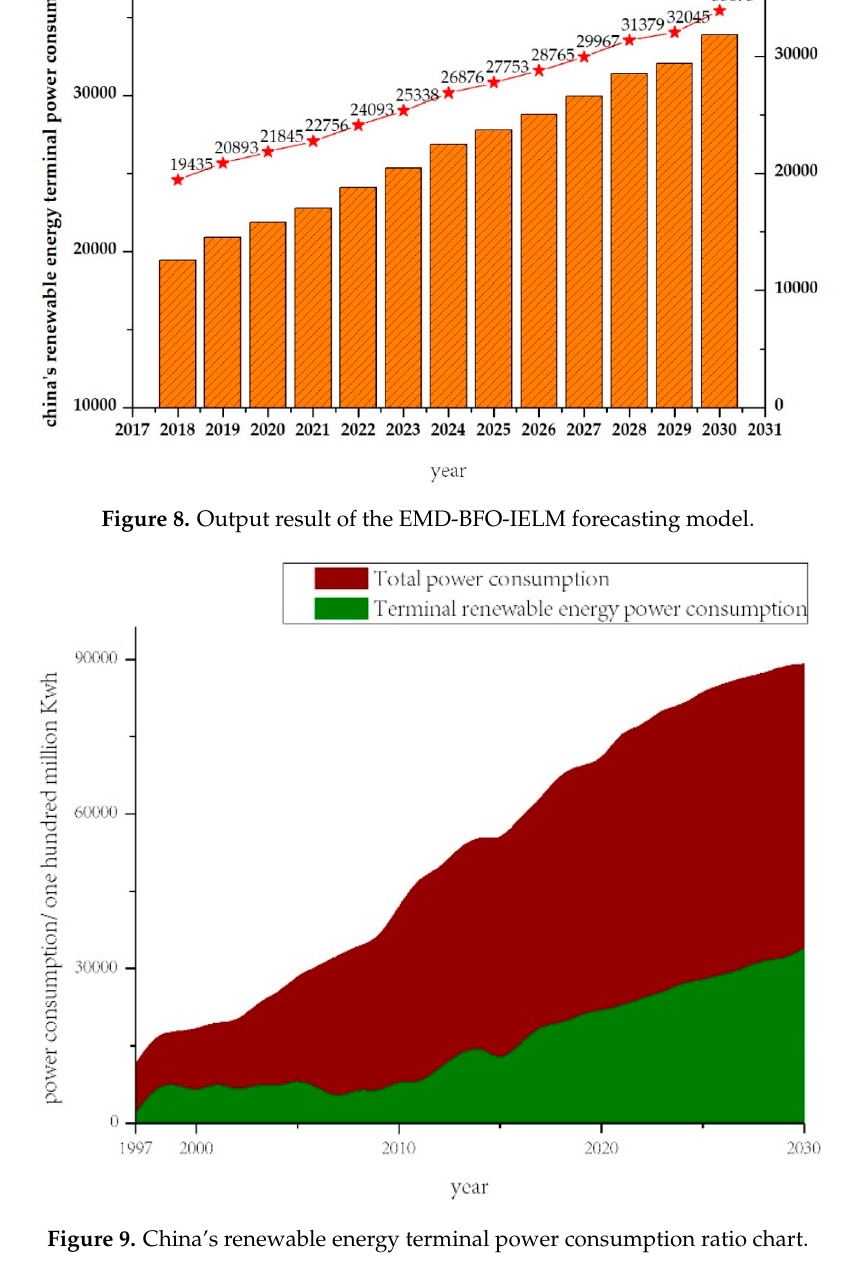
Figure 9. China’s renewable energy terminal power consumption ratio